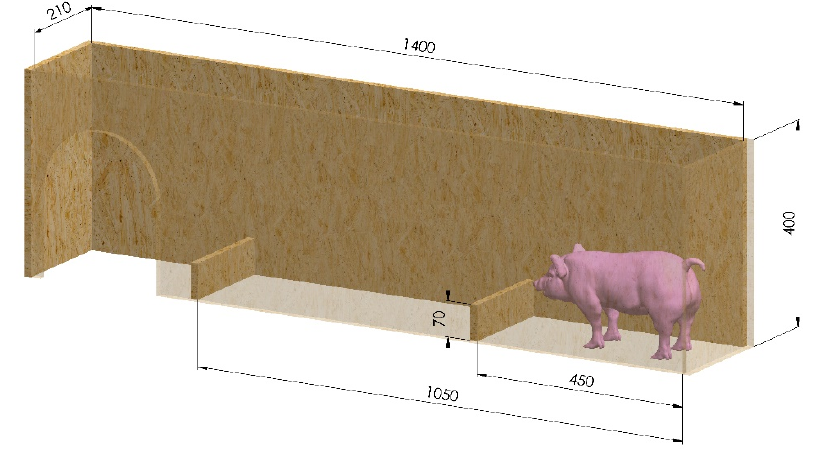
Figure 1. Illustration of the handling chute according to Bilsborrow et al. [28]; dimensions = internal dimensions in mm.